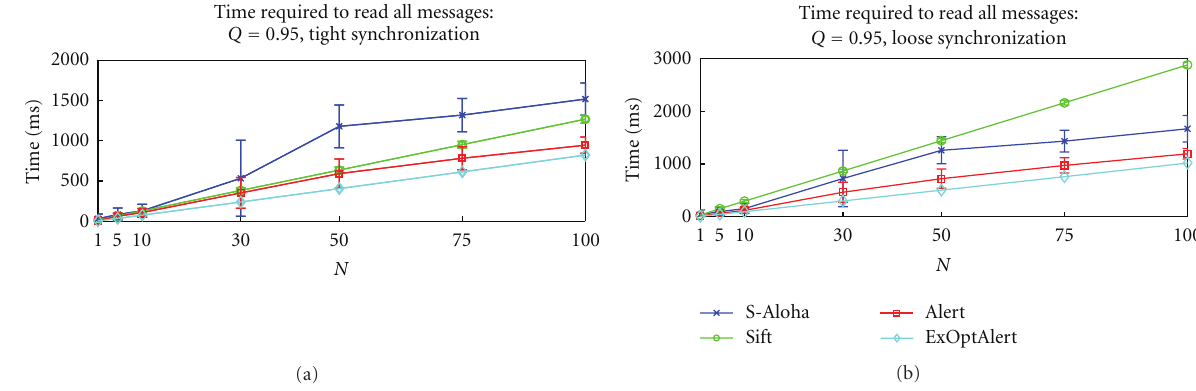
Figure 13: Average time required to receive all messages with Q = 0 .